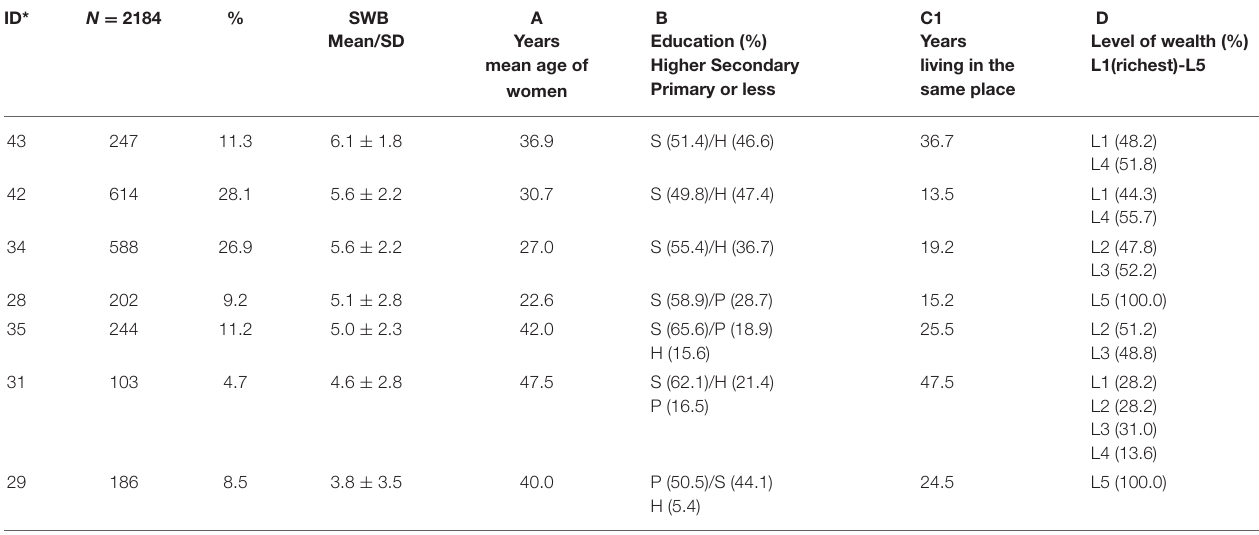
TABLE 6 | Detailed description of the terminal iC&RT nodes (defined women groups) of subjective wellbeing of Montenegrin women.